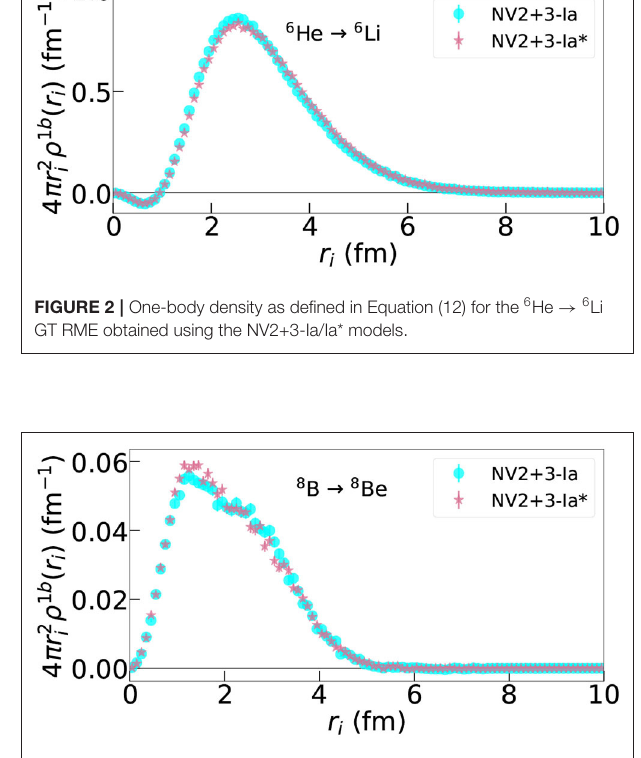
FIGURE 3 | One-body density as defined in Equation (12) for the 8 B → 8 Be GT RME obtained using the NV2+3-Ia/Ia*